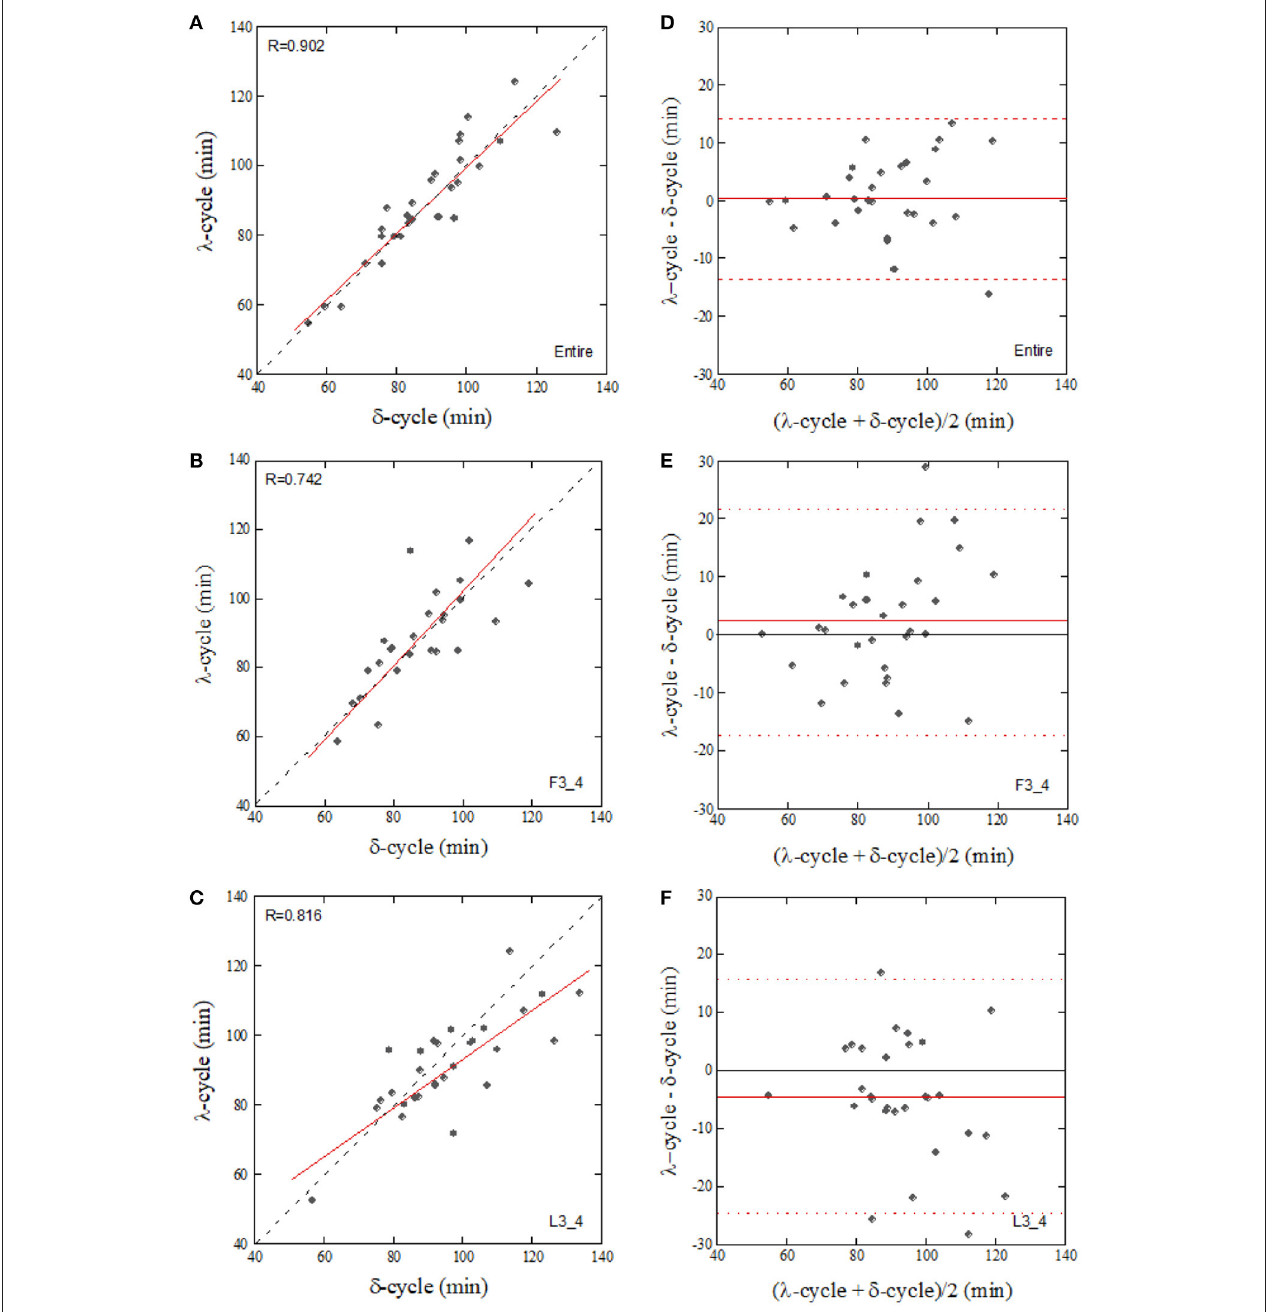
FIGURE 7 | Correlation of the sleep-cycle estimated from δ -wave and λ ACFs calculated from the entire ( A , Entire), first three-quarters ( B , F3_4), and last three-quarters ( C , L3_4) of the sleep period and their Bland-Altman plots (D–F) . The dotted and solid lines in (A–C) represent the identity line and linear regression line, respectively. Horizontal broken lines in (D–F) , upper and lower limits of agreement (